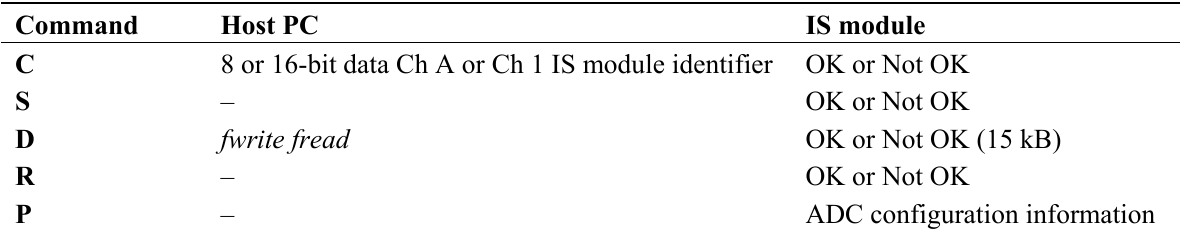
Table 1. Communications summary: data packets and